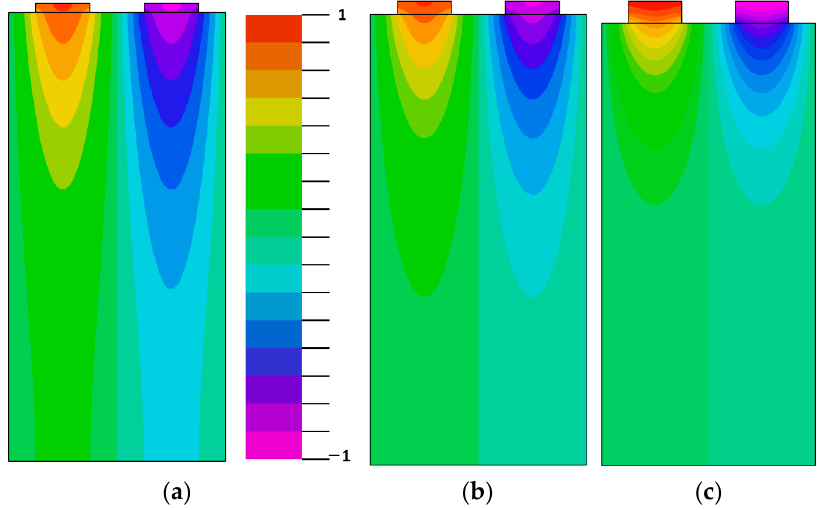
Figure 9. Spatial distribution of normalized amplitude U 2 into the substrate depth for different IDT electrode thicknesses on the Y-cut and the X-axis wave propagation direction in KTP (calculated by FlexPDE [51]). One period of IDT containing the infinite periodic electrode structure with period λ = 20 μ m is shown: ( a ) the electrode thickness h/ λ = 4% and resonance frequency f 0 = 210.6 MHz (resonance frequency f 0 = 210.0 MHz calculated by our FEM/BEM program [45]); ( b ) the electrode thickness h/ λ = 6% and resonance frequency f 0 = 205.6 MHz (resonance frequency f 0 = 205.7 MHz calculated by our FEM/BEM program); ( c ) the electrode thickness h/ λ = 10% and resonance frequency f 0 = 190.8 MHz (resonance frequency f 0 = 190.8 MHz calculated by our FEM/BEM program).